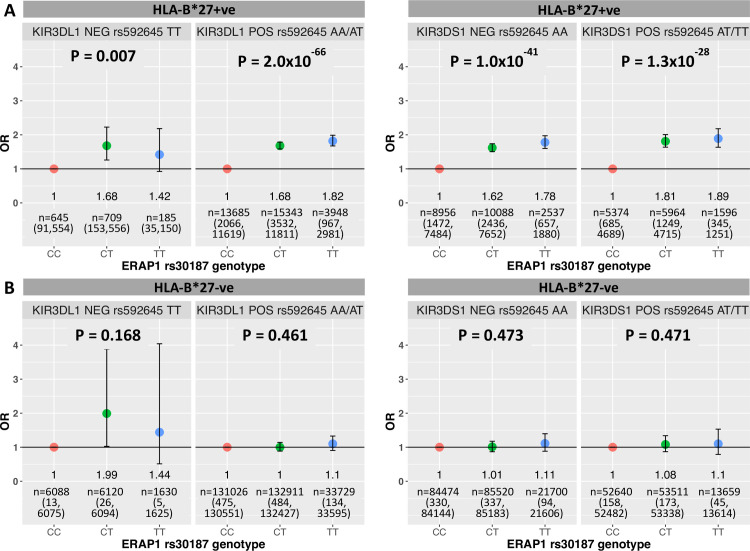
Association of ERAP1 SNP rs30187 with AS in HLA-B*27+ and HLA-B*27- cohorts, split by carriage of KIR3DL1 or KIR3DS1.Points denote the OR of disease attributed to each successive increase in rs30187 risk allele [T] count in HLA-B*27+ (A) and HLA-B*27- (B) individuals split by presence/absence of KIR3DL1 (left) or KIR3DS1 (right) defined using the KIR3DL1/S1 locus tag SNP rs592645. P-values are derived from the logistic regression of genotype (additive) against disease status, ORs are derived from the exponentiated beta coefficient for each genotype class, treating the protective genotype rs30187 [CC] as baseline (OR = 1). The number of individuals in each KIR-HLA-ERAP genotype split group is indicated in the form n = total number (number of cases, number of controls). ORs are enumerated below points. Bars indicate 95% confidence interval.